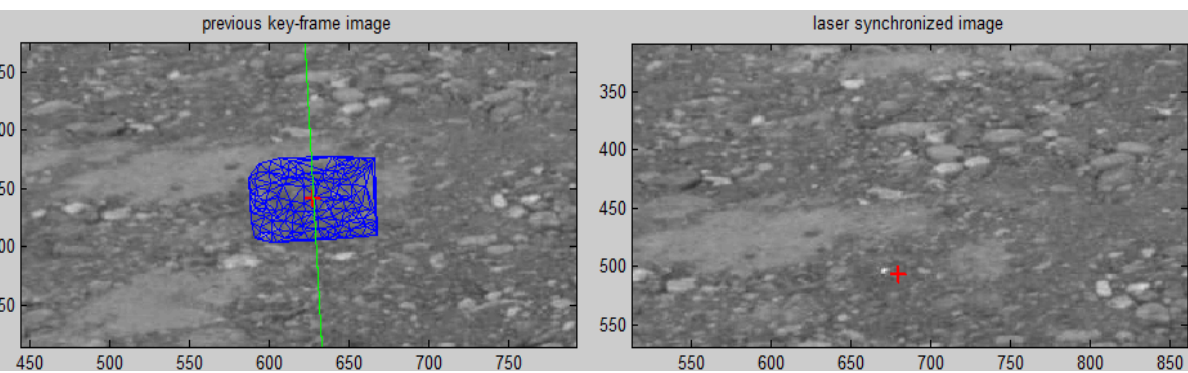
Figure 11. The laser pointer projection (right image, marked in red) is matched on the key-frame (marked in red) through disparity consistency constraints by Delaunay triangulation (blue), checked by the laser pointer’s conjugate epipolar line